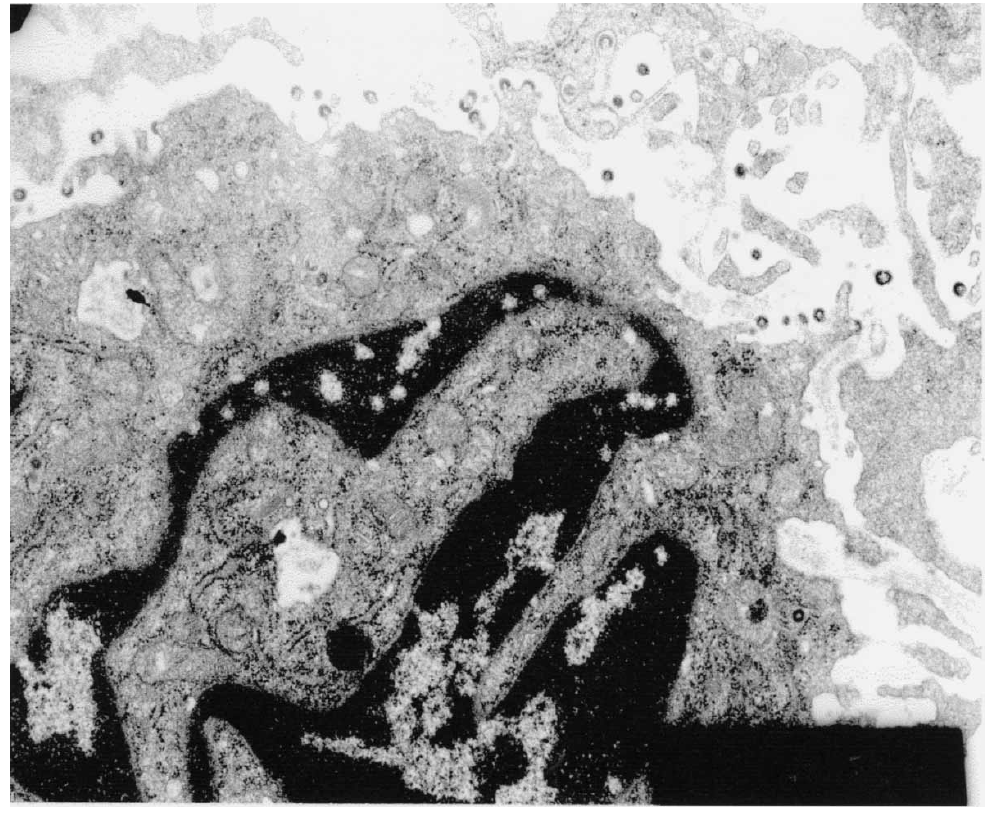
Fig. 2. Kaposi sarcoma cell with budding retroviral particles that failed to react with commercial kits aimed at HTLV-I or HIV-1 structural proteins. F. Gyorkey y and J.G. Sinkovics, VA Medical Center, Houston TX, 1983